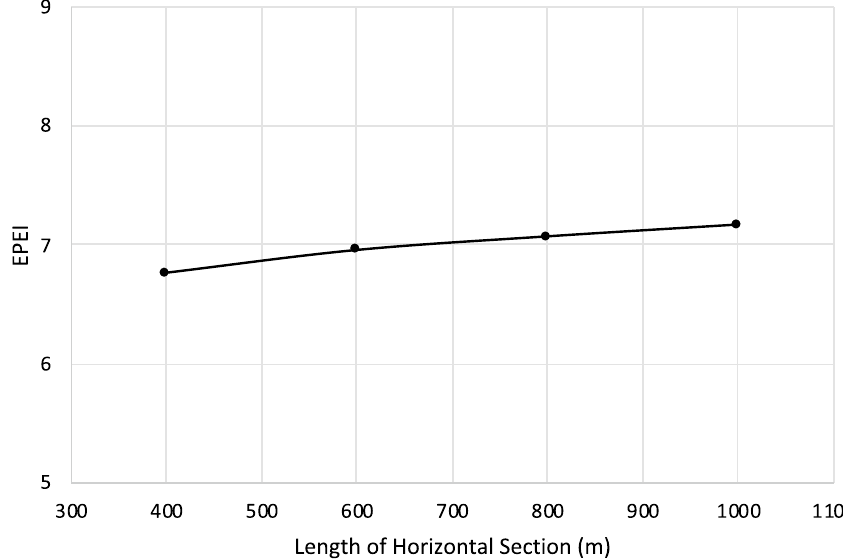
Fig. 11 EPEI versus the length of the horizontal section for the closed-loop system at 200 m 3 /day fluid flow